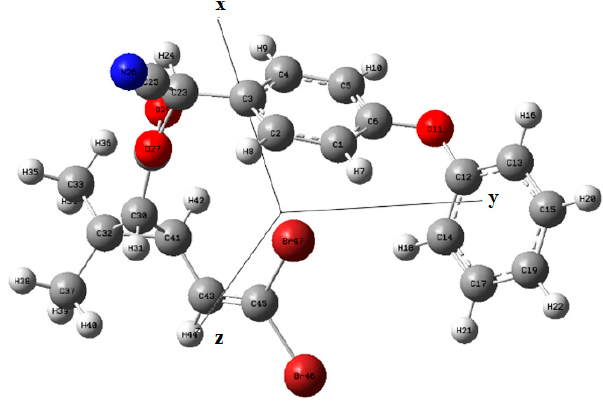
Figure 1. Simulated molecular structure of deltamethrin by DFT.